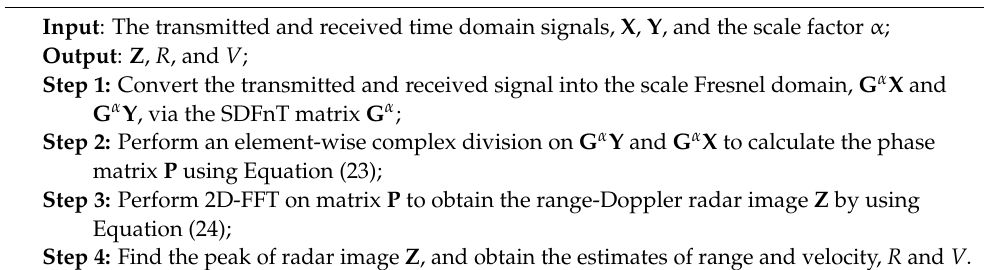
Algorithm 1 Proposed SDFnT-based parameter estimation algorithm for OFDM